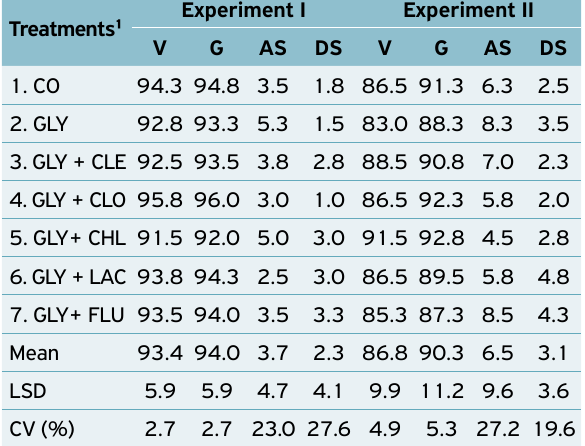
Table 8. Variables related to quality of RR2 soybean seeds² subjected to application of glyphosate, alone or in combination, at post‑emergence (V4). Piracicaba, state of São Paulo, 2013/14 season (experiment I), and 2014/15 season (experiment